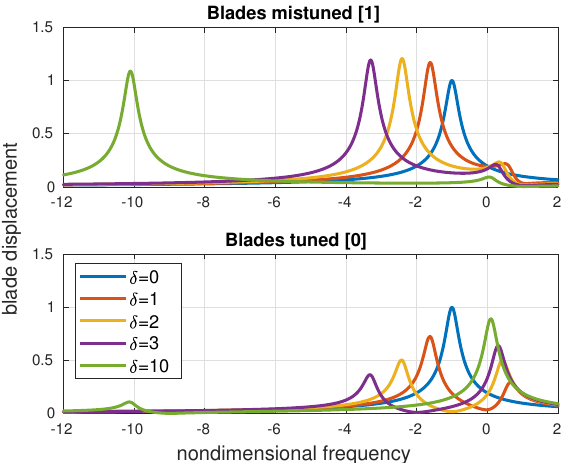
Figure 7. Asymptotic ROM results of the alternate mistuning configuration for variable mistuning size; ( top ) mistuned blades [1], ( bottom ) tuned blades